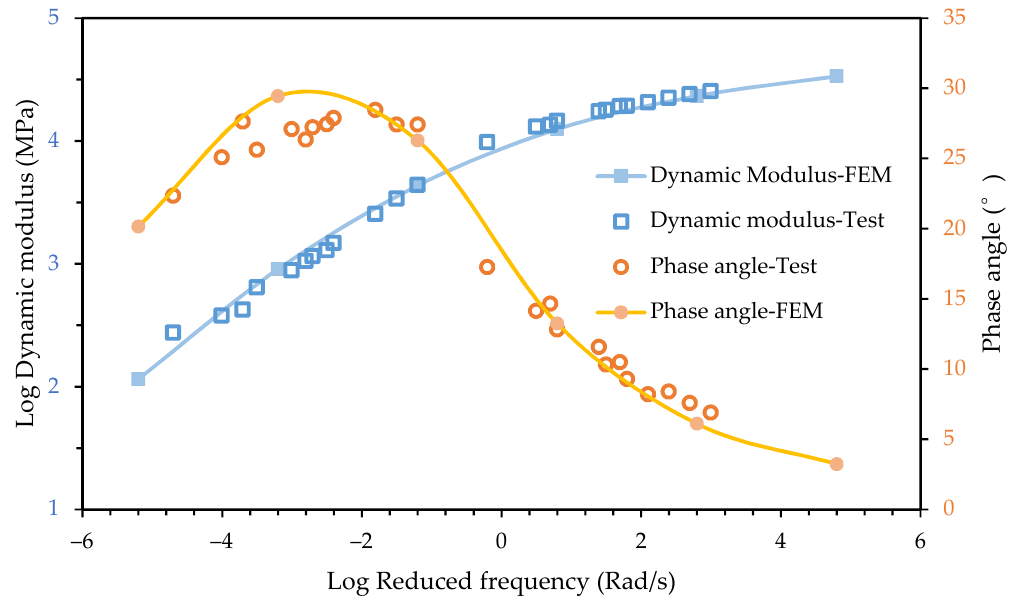
Figure 12. Improved prediction of the dynamic modulus and phase angle master curves.